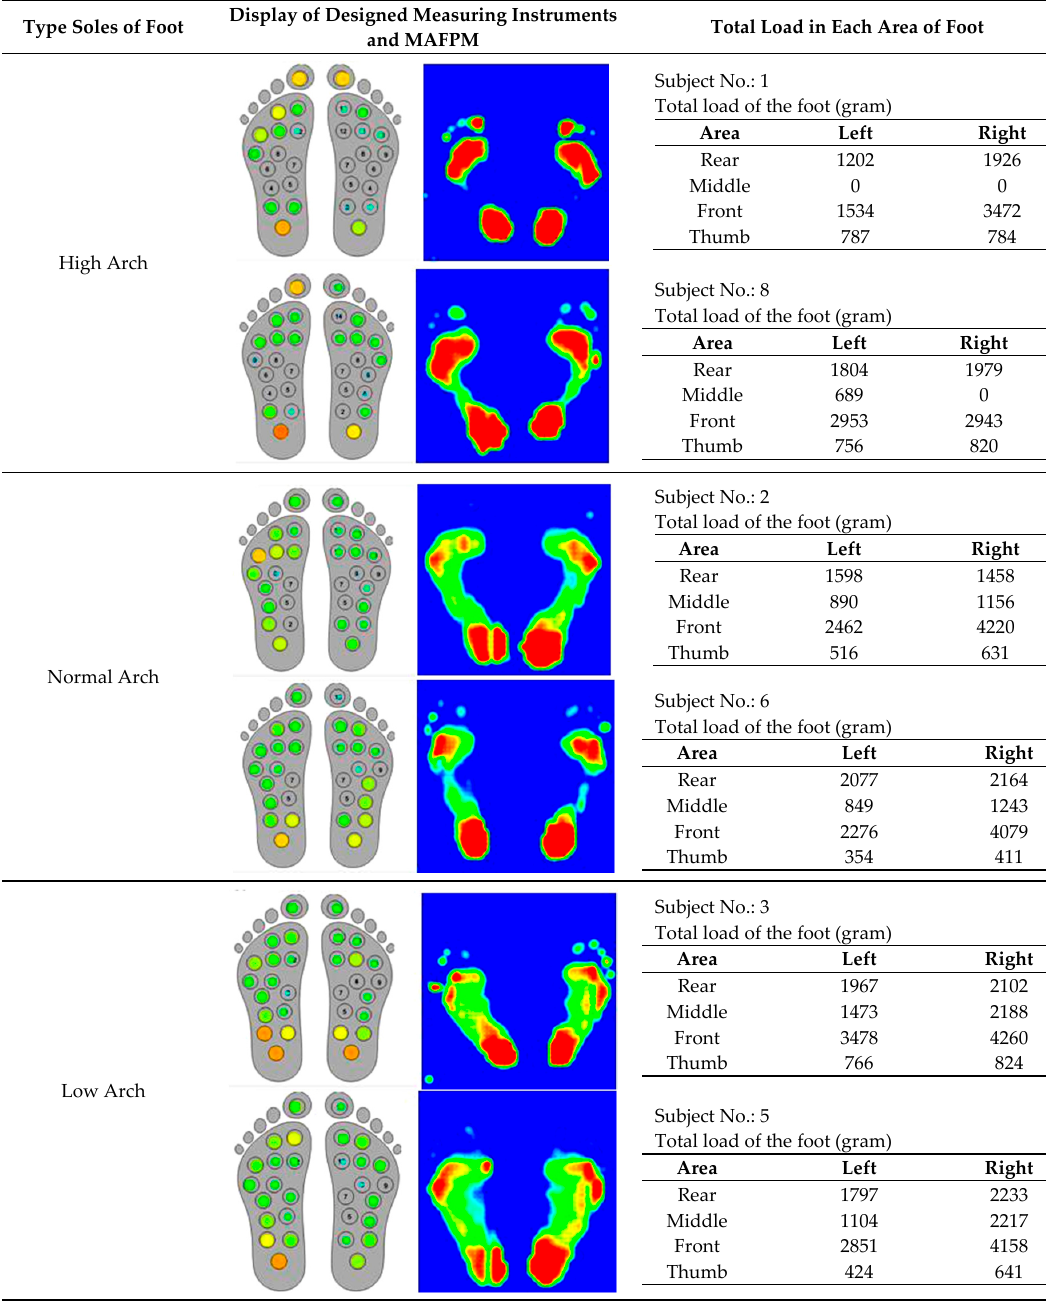
Table 6. Sample comparison of measuring instrument results designed with MAFP measurement (sorted against type soles of foot).